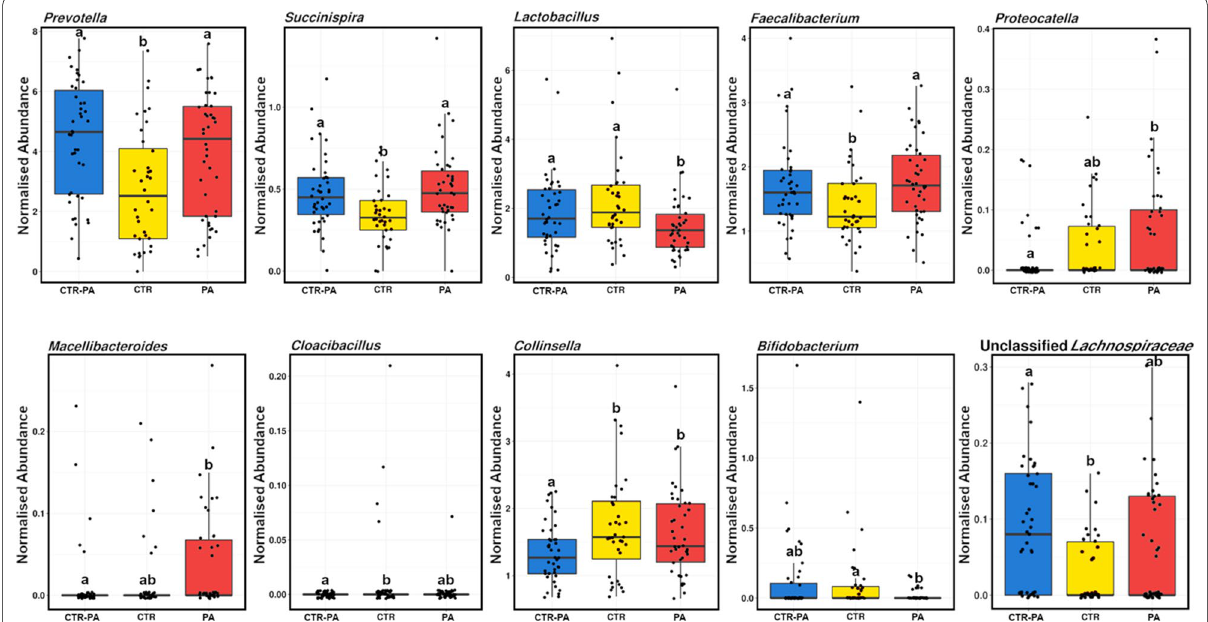
Fig. 7 Genera significantly altered ( P < 0.05) in the faeces of 35-day old piglets reared on sows fed different dietary treatments (CTR, CTR-PA and PA). Subscripts that differ denote a significant